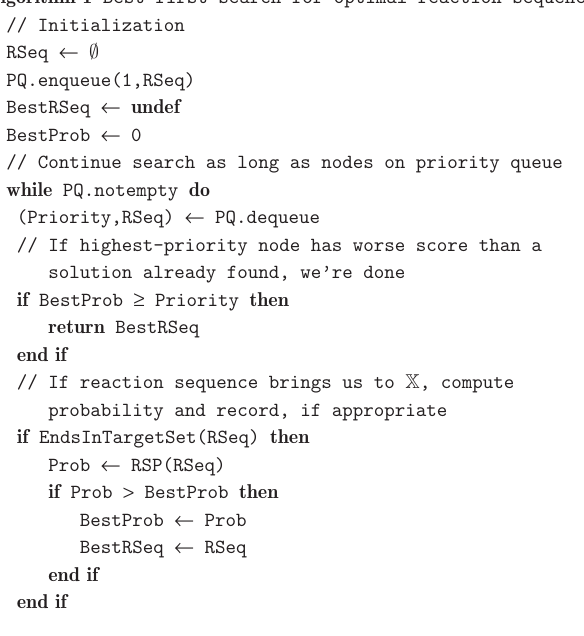
Algorithm 4 Ant Colony Optimization (ACO)